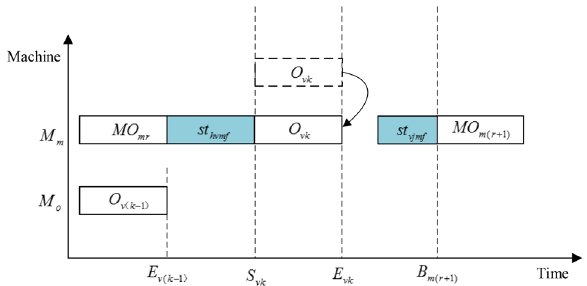
Figure 4. The decoding diagram of operation O vk when E vk ≤ B m ( r + 1 ) − st vjmf .